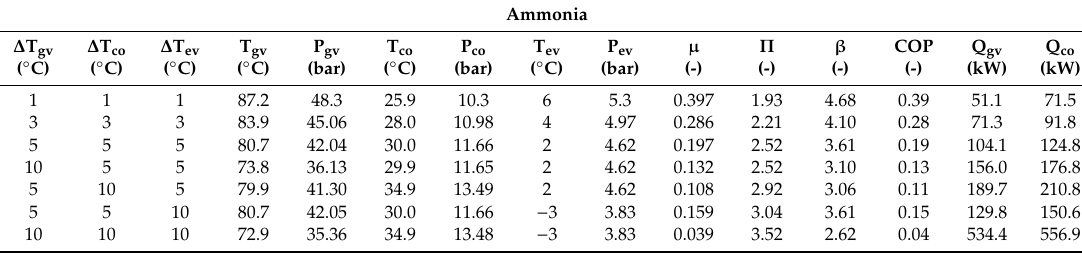
Table A2. Thermodynamic analysis results for